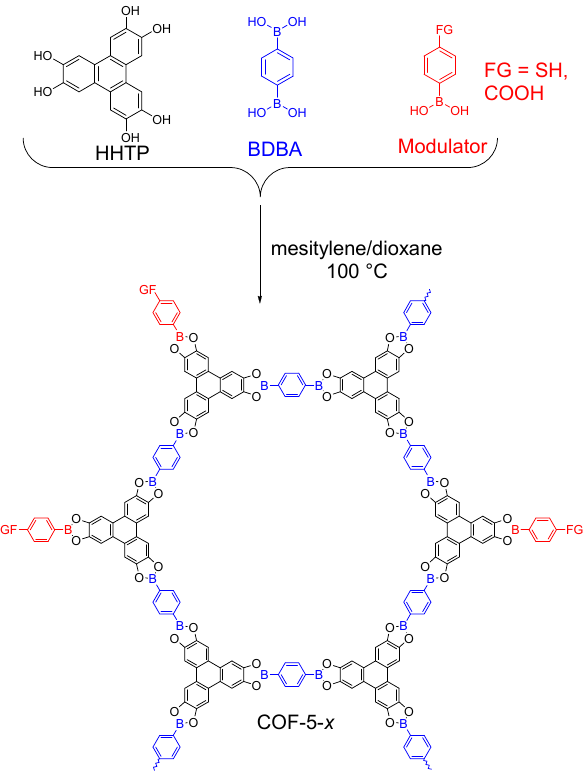
Figure 8. The modulation approach to synthesize COF-5- X via the cross-condensation of HHTP and 1,4-diboronic acid combining with terminal boronic acids with various functional groups to achieve higher crystallinity and external functionalities.